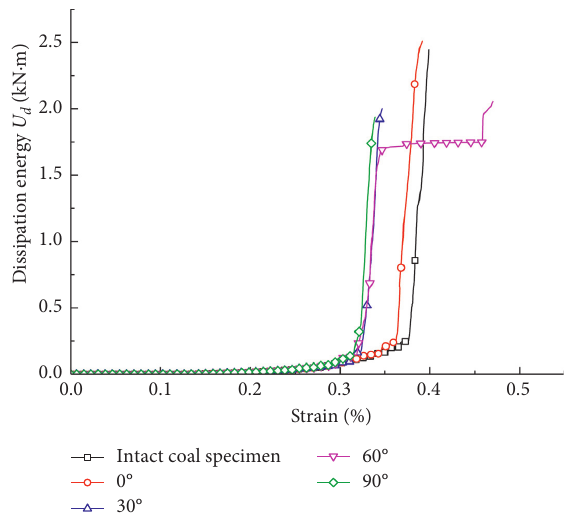
Figure 14: Curve of dissipated energy and strain.